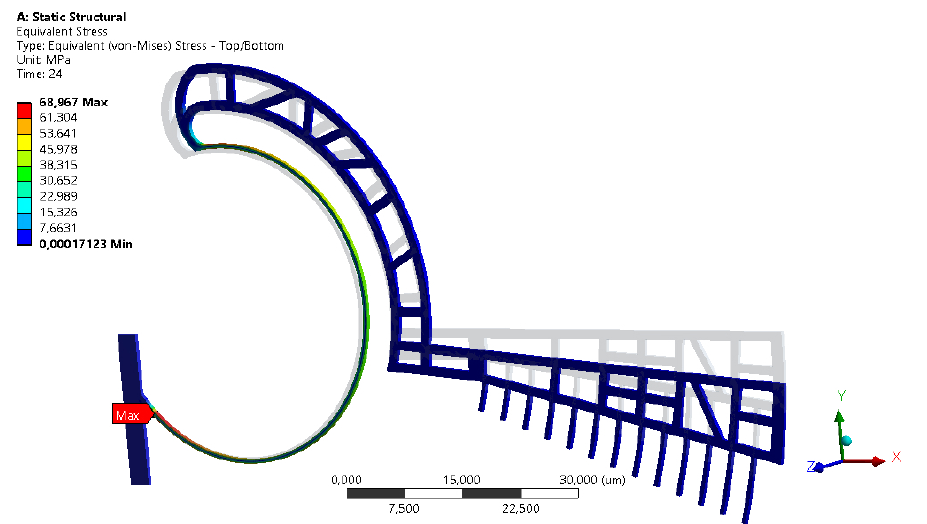
Figure 8. Second layout: neutral and deformed configurations, and stress distribution on the